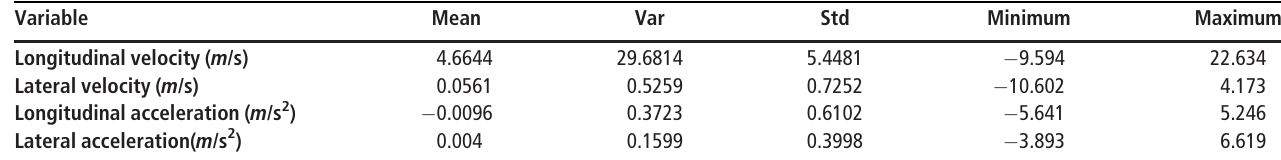
Table VI Statistical calculation of experimental data Variable